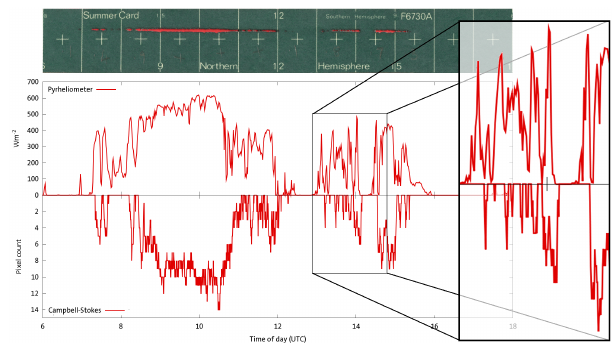
Fig. 5. Comparison between the solar data extracted from a rectified and registered Campbell-Stokes recorder card and that from the co-located pyrheliometer at Lerwick. These data are for 21 April 2003 The card image has been cropped and scaled to match the time scale used for the data panels. There is a clear correlation between the data from the two sources in both time and amount despite this being only a moderately sunny day.